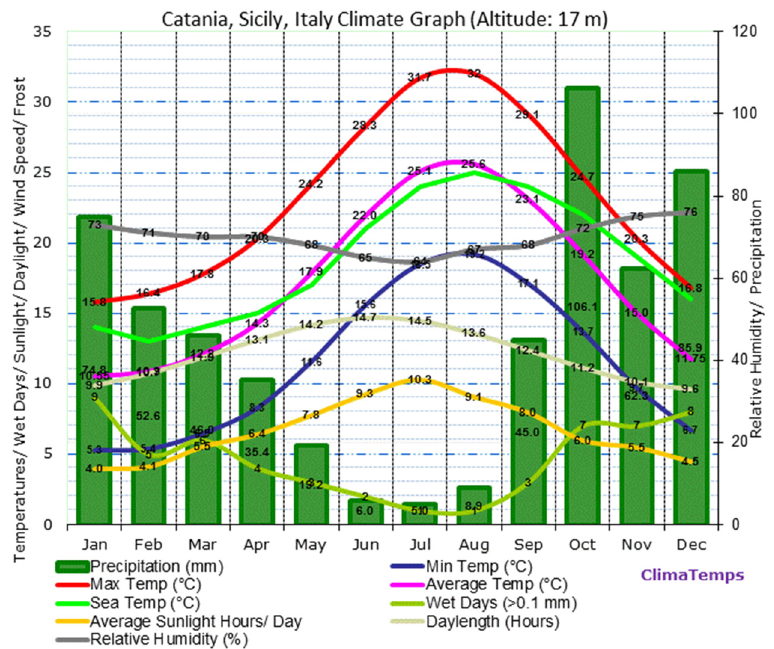
Figure 5. Trend of main climate indicators of the city of Catania (monthly averages).